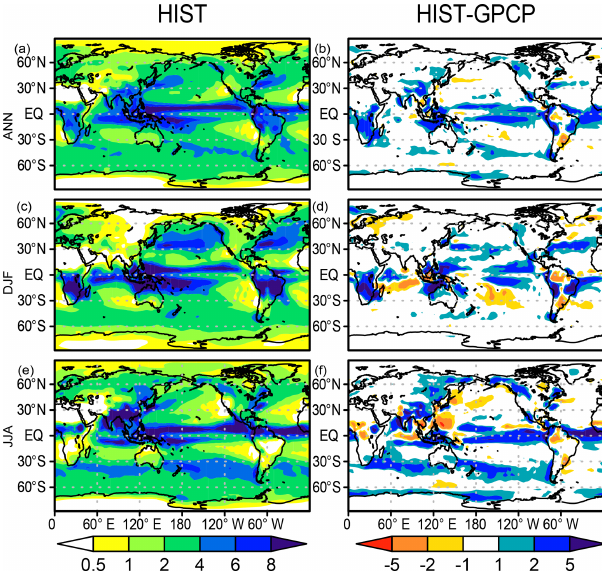
Figure 4. Precipitation distributions (mmd − 1 ) in the HIST simu- lation and biases relative to the GPCP dataset (Adler et al., 2003) for (a, b) annual, (c, d) DJF, and (e, f) JJA means averaged over